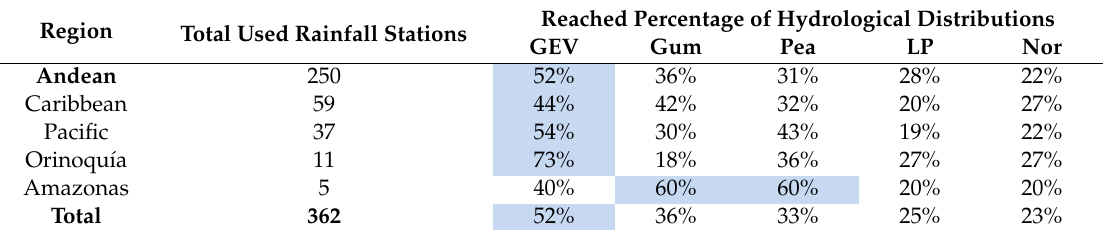
Table 4. Selection of a hydrological distribution based on the minimum value of chi-squared test. Region Total Used Rainfall